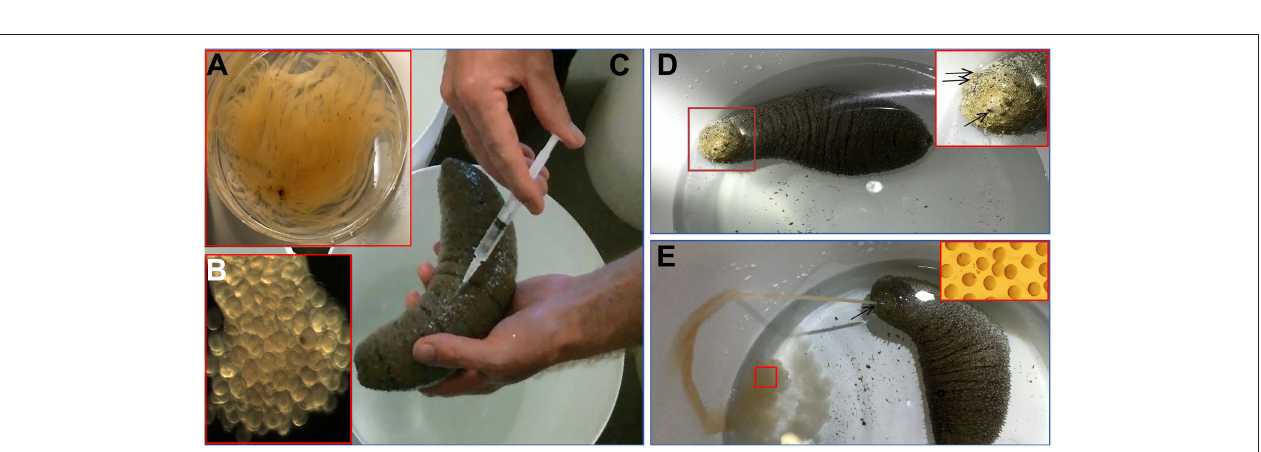
FIGURE 5 | Summary of Holothuria scabra spawning bioassay with recombinant RGP. Negative controls included filtered artificial seawater (FASW) and yeast solution without RGP. Test solutions included crude RGP supernatant (CS) and His and Amicon-purified RGP (HR). The first injection was a 2mL volume and the second was a 3mL volume.